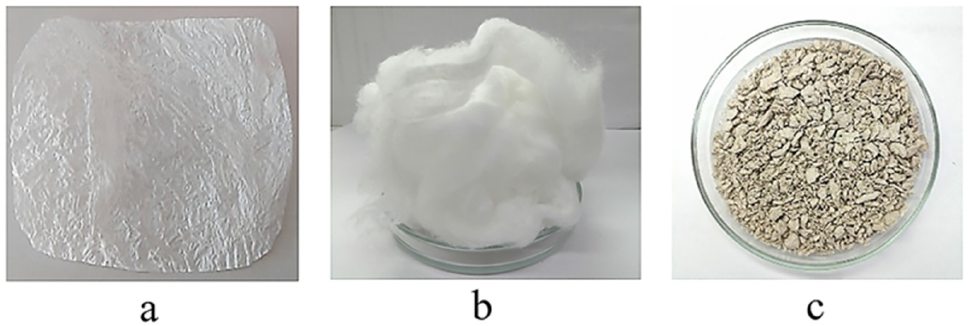
Figure 1. Photographs of cellulose samples: ( a ) BC, ( b ) synthetic cellulose and ( c ) Miscanthus ‐ derived cellulose.